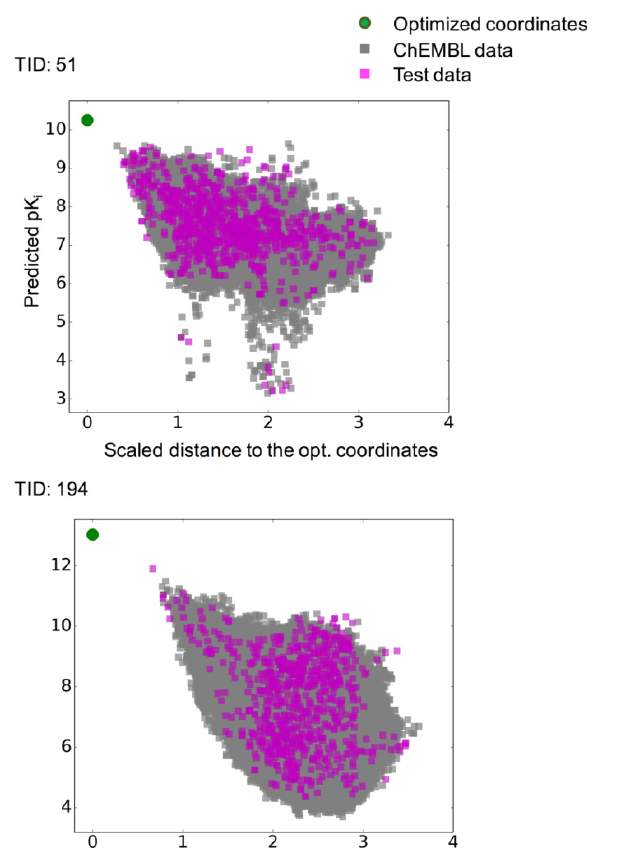
Figure 8. Activity prediction for ChEMBL compounds. For the two activity classes from Figure 5, predicted pK the scaled distance of corresponding compounds to the optimized coordinates. ChEMBL compounds (gray squares) and test compounds according to Figure 5 (magenta squares) falling inside the applicability domain are shown. Optimized coordinates are displayed as a green